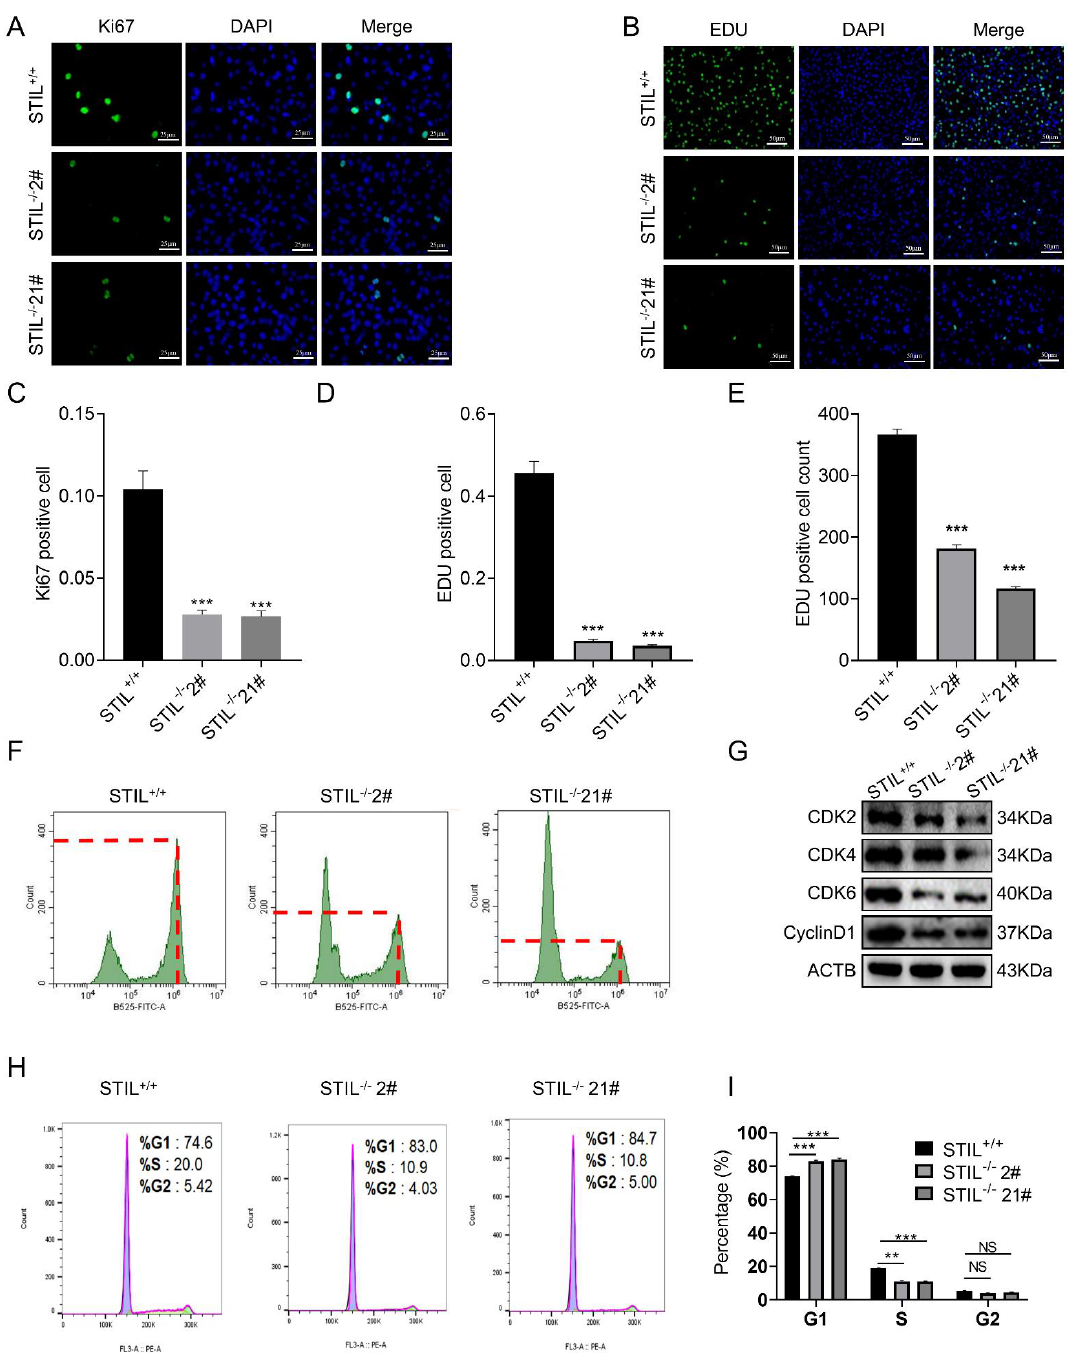
Figure 4. In the UMUC3 cell line, STIL played a vital role in the proliferation and cell cycle of BC. Representative microscope images of ( A ) Ki67 staining and ( B ) EDU staining. The green color represents Ki67 and EDU and the blue color represents DAPI. The quantitative analysis of ( C ) Ki67 staining and ( D ) EDU staining. ( F ) Representative images of flow cytometry for EDU staining and ( E ) quantitative analysis of EDU positive cell count. Ten thousand cells were counted in each sample. The ordinate of the second peak is the number of EDU-positive cells, and the fluorescence intensity (abscissa of the graph) was 10 6 at this point. ( G ) Representative images of Western blotting of cyclin D1 and cell cycle-related proteins CDK2/4/6. ( H ) Representative images of flow cytometry for propidium iodide (PI) staining and ( I ) quantitative analysis of cell cycle phase. EDU, 5-ethynyl-2- deoxyuridine (** p < 0.01 and *** p < 0.001; NS, no